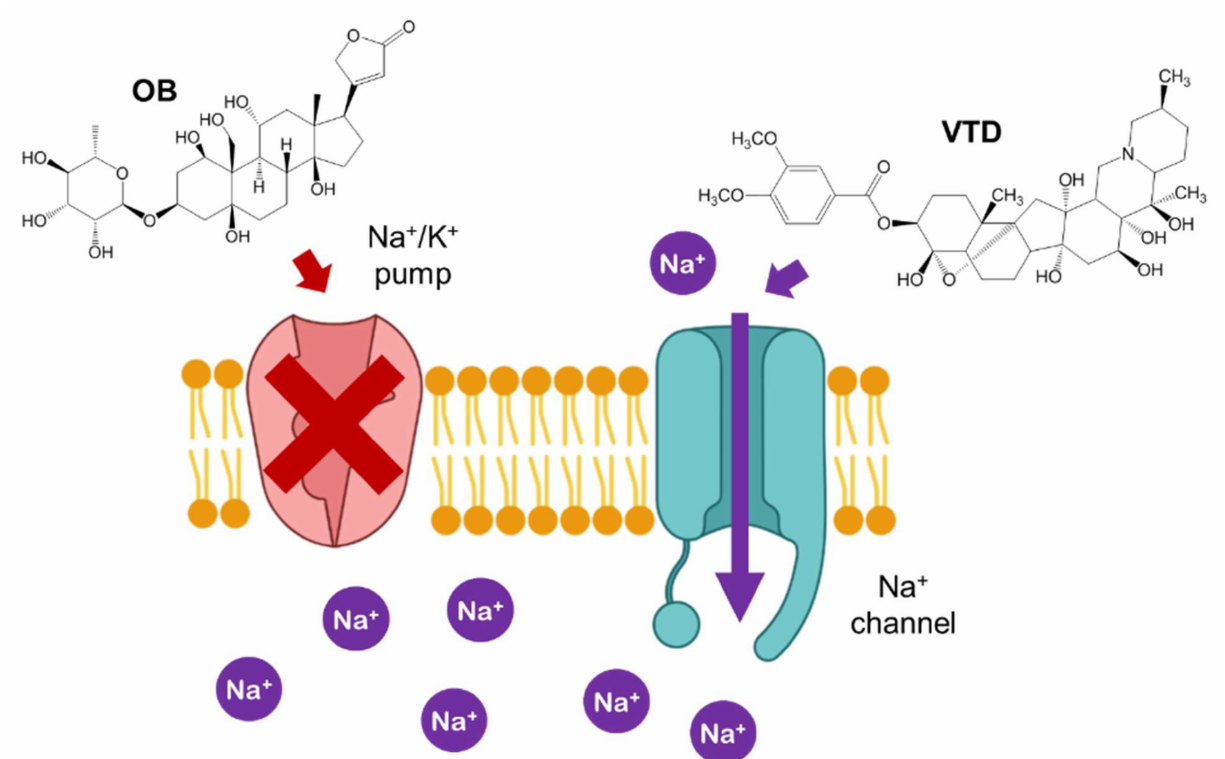
Figure 8. Structure of OB and effect of VTD and OB in the Na + cell